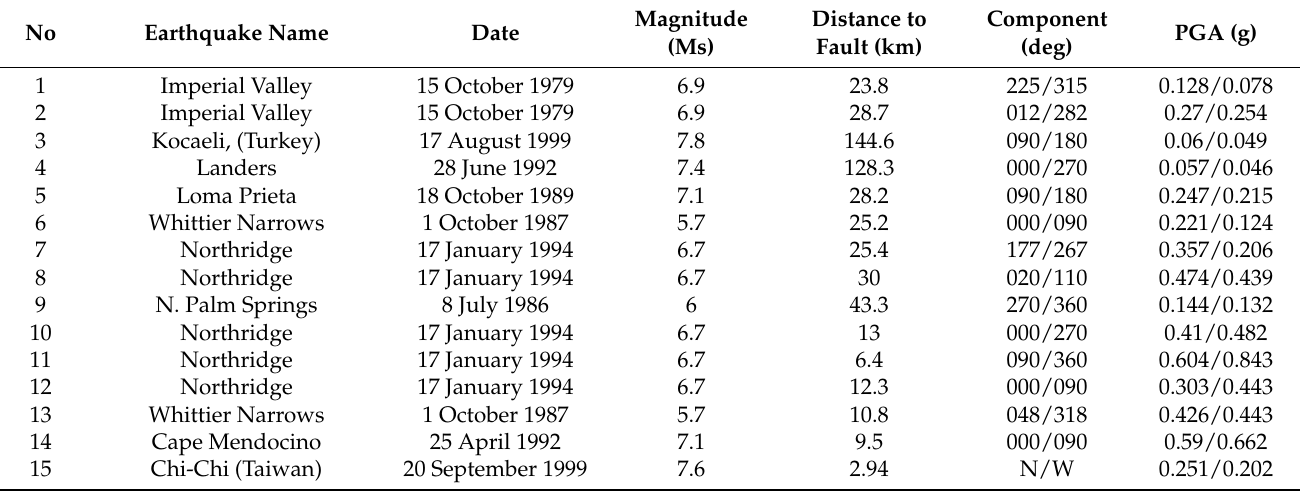
Table A1. Data of the 65 selected seismic excitations.